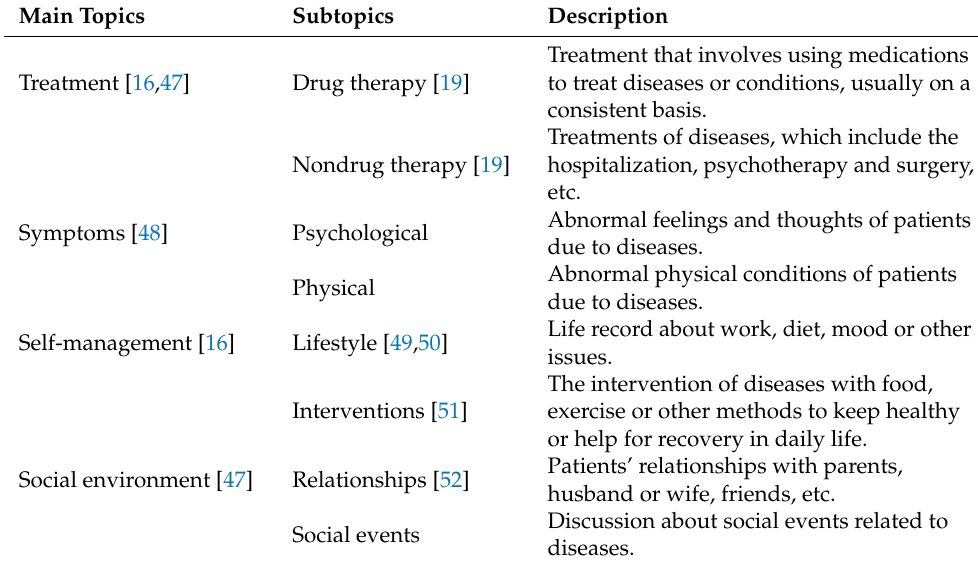
Table 3. The two-layer theme classification scheme for the texts in online disease communities.